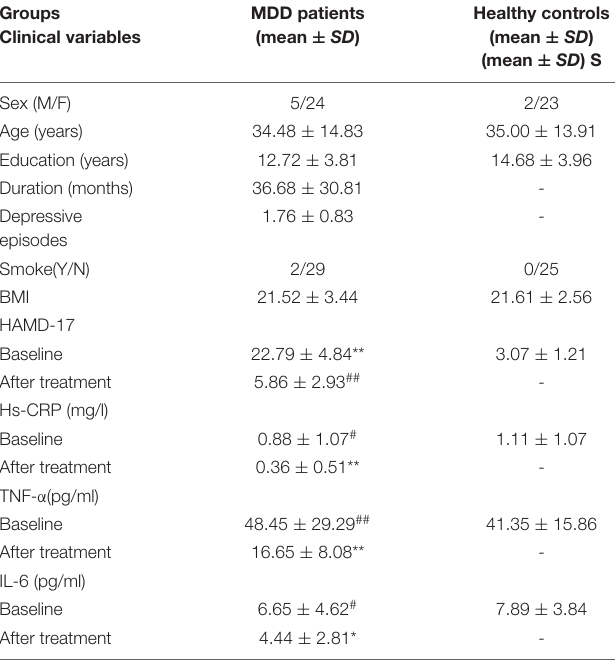
TABLE 1 | Demographic and clinical data for MDD participants and healthy controls. Groups Clinical